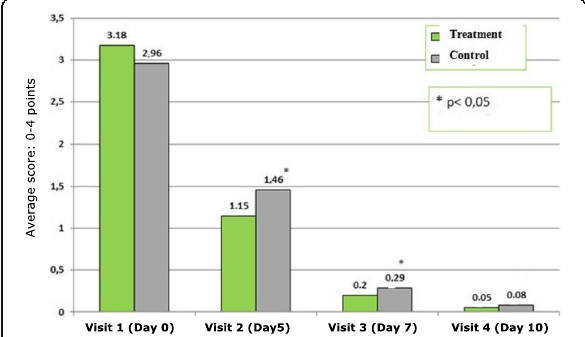
Fig. 1 Physicians ’ assessment of dynamics of nasal congestion symptoms at visits 1 to 4. Average score (MSS scale: 0 – 4 points). * p